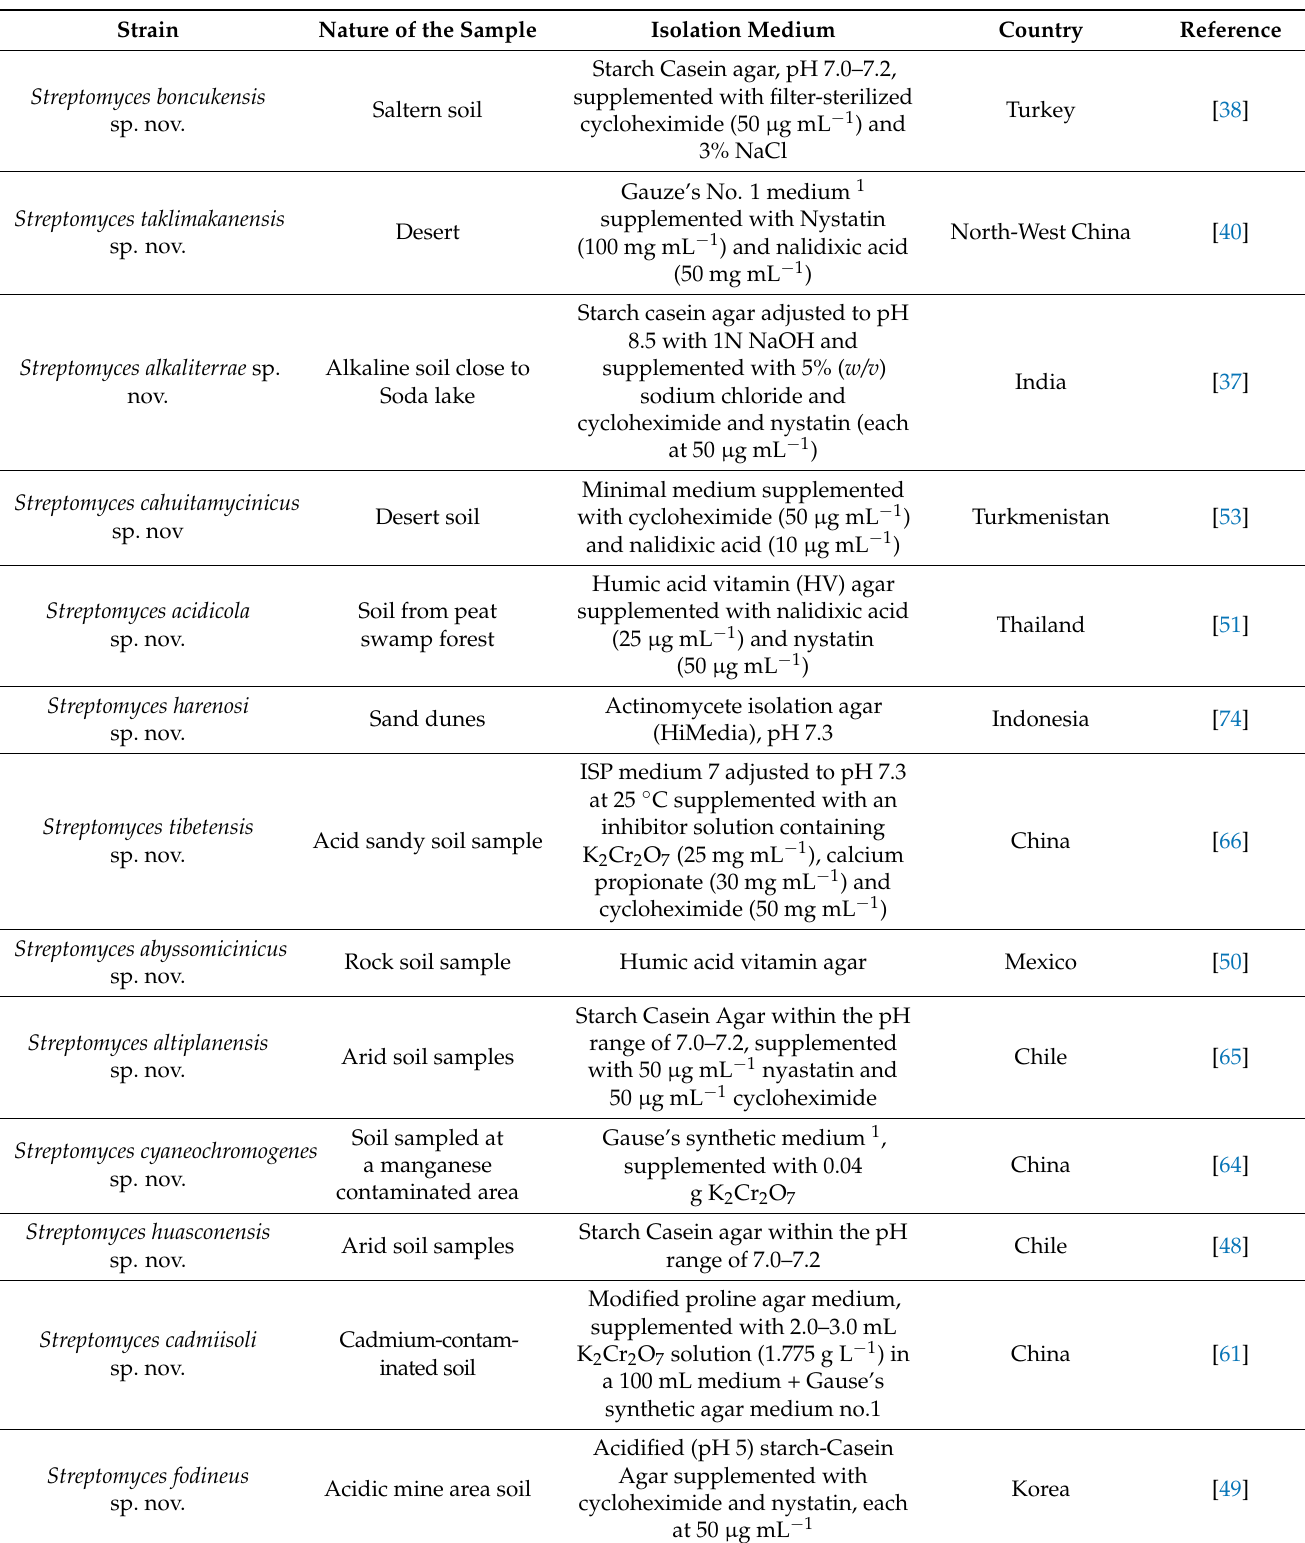
Table 1. Novel Streptomyces spp. reported from extreme environments between 2015 and